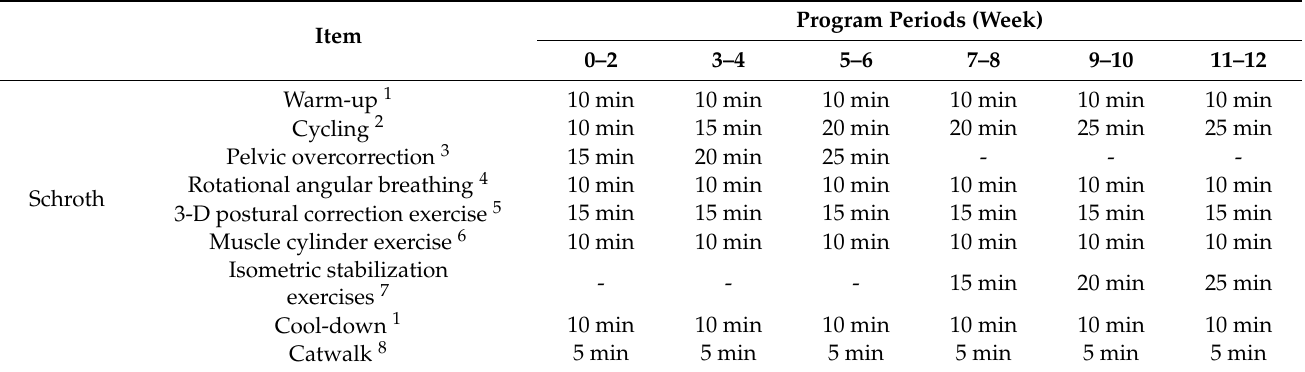
Table 2. Rehabilitation exercise program for patients with